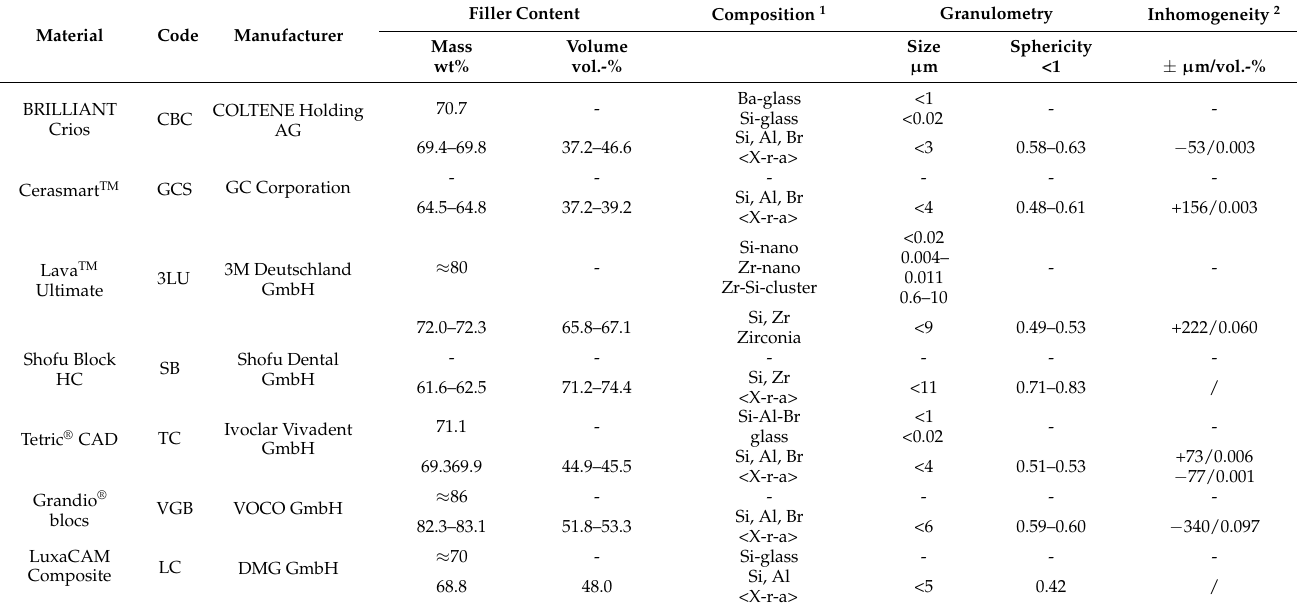
Table 6. Overview of characteristic parameters (top: manufacture data; bottom: own measured